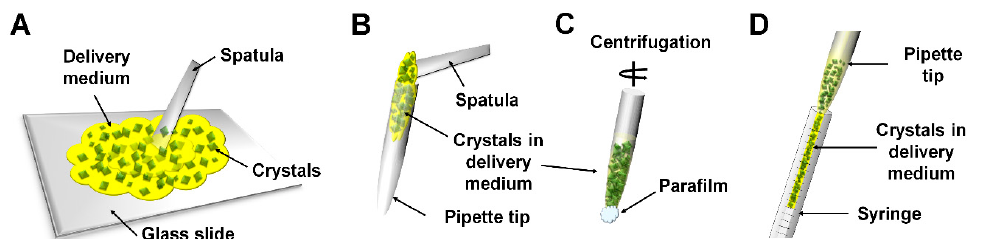
Figure 3. Schematic representation of manual mixing of crystals and delivery medium. ( A ) The crystals and the delivery medium are mixed using a spatula under a glass slide. ( B ) The mixture is transferred to the dispenser tip. ( C ) The mixture is then moved to the end of the tip using centrifugation. ( D ) The mixture is transferred to the syringe or sample injector. This figure was drawn based on Reference [52].